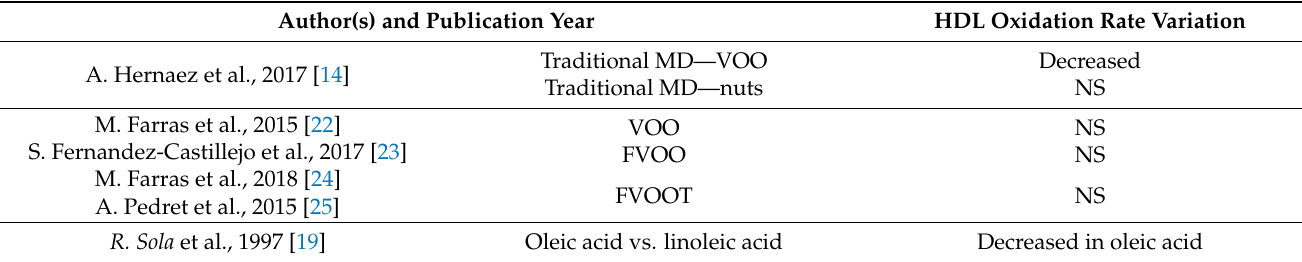
Table 4. High-density lipoprotein (HDL) oxidation.